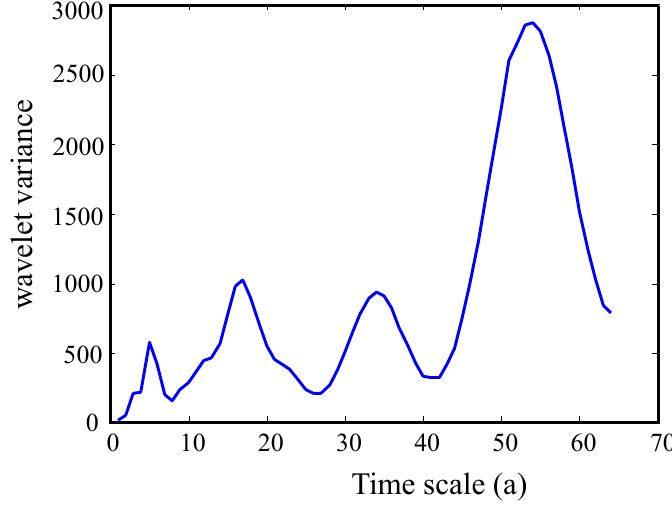
Figure 8. The curves of wavelet variance of sediment discharge at Tongguan station.